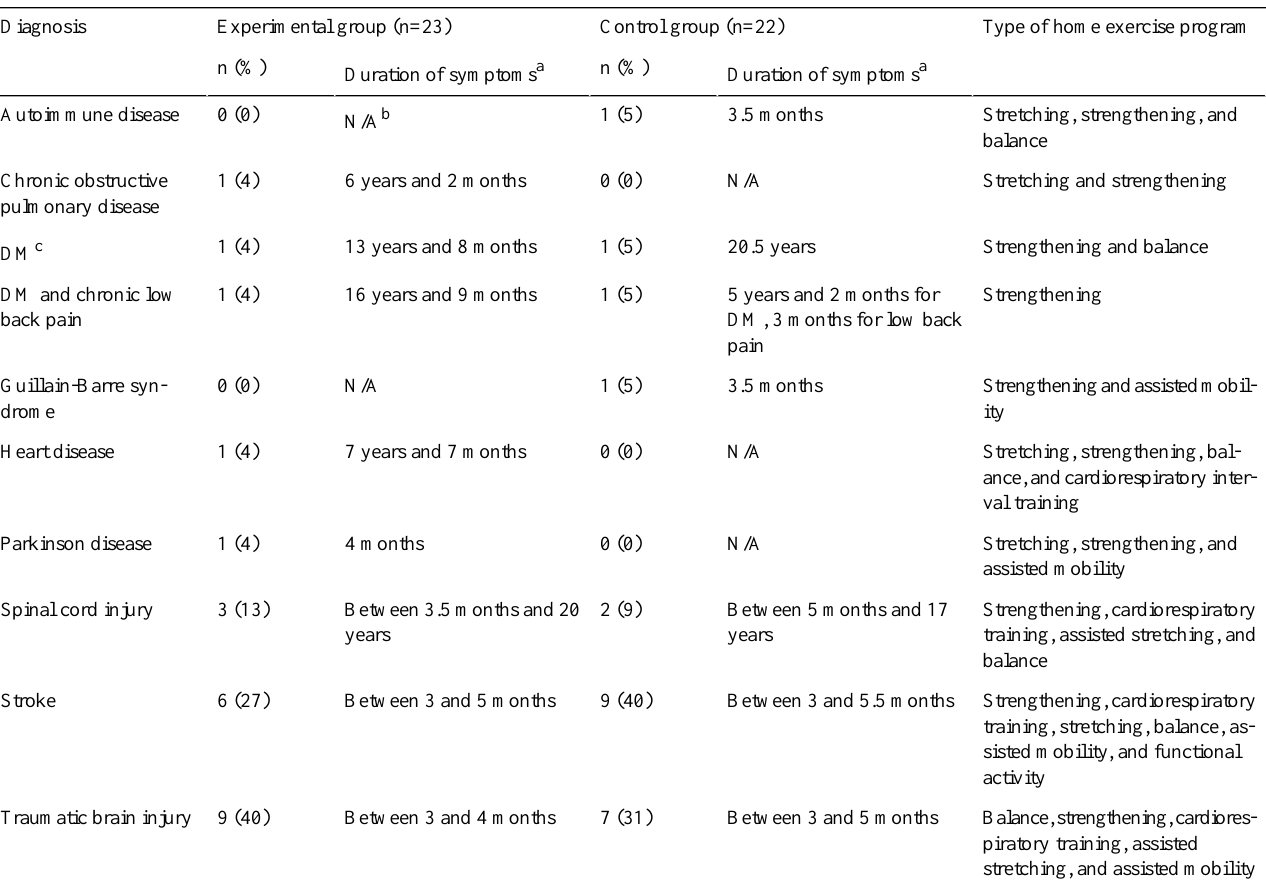
Table 2. Clinical data of the participants per allocated group